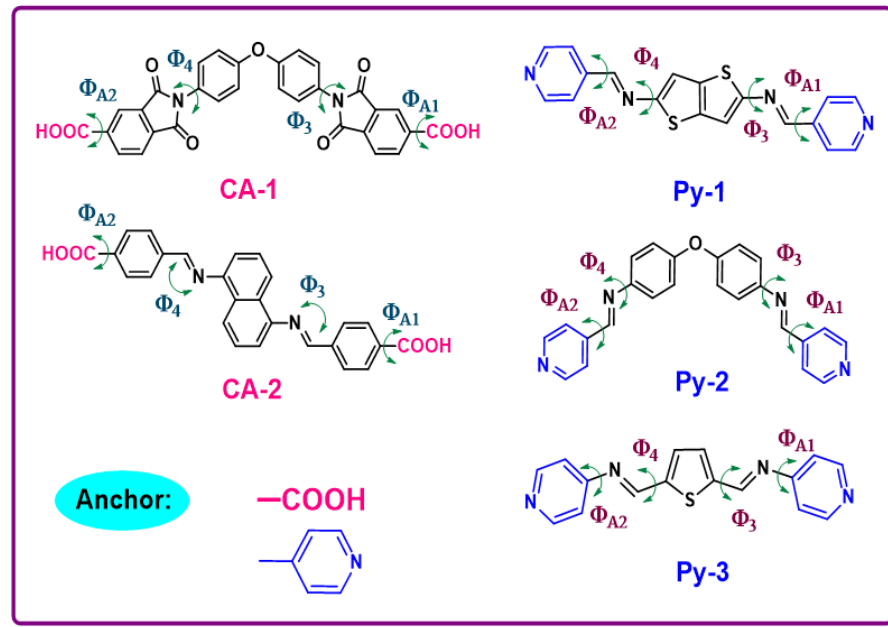
Figure 2. Molecular structures of the new sensitizers with critical dihedral angles positions. Table 1. Calculated Critical Dihedral Angles of New Sensitizers at Ground State (S0) Geometry.